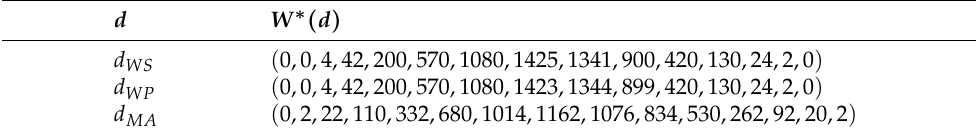
Table 2. W ∗ ( d ) of d WS , d WP and d MA